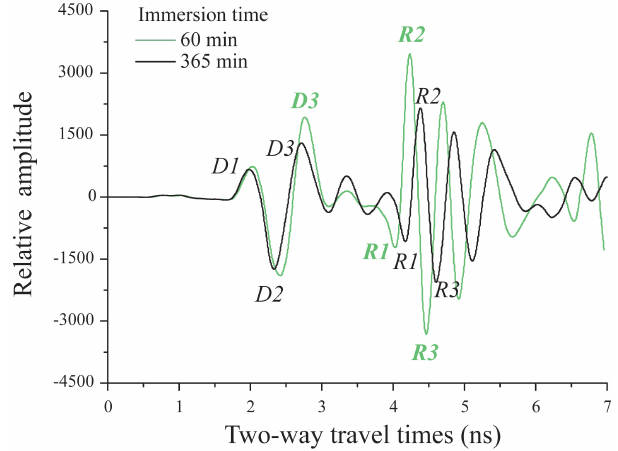
Figure 3. Effect of water immersion on reflected peaks.